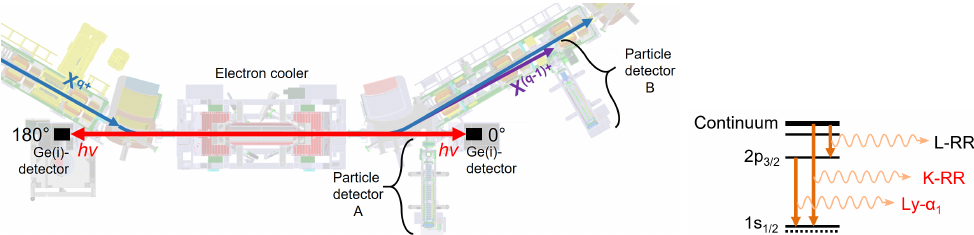
Figure 3. Top view of the electron cooler section with a schematic of the setup for X-ray spectroscopy (left image). The right image schematically illustrates an example cascade pathway for X-ray emission following the capture of a free electron into a bare ion forming an H-like X-ray-emitting product ion.